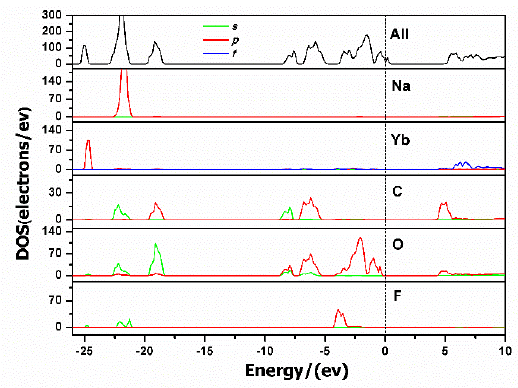
Figure 7. Total and partial densities of states for Na 4 Yb(CO 3 ) 3 F.